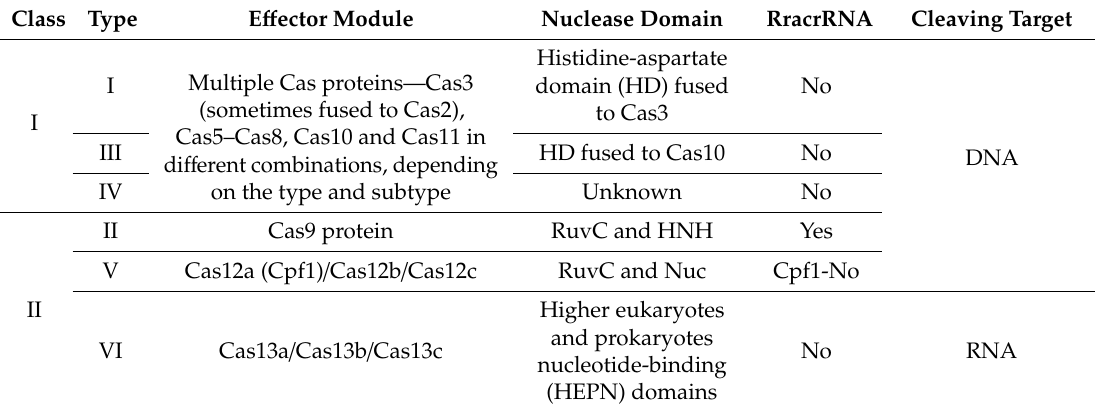
Table 1. Overview of CRISPR–Cas classification and characteristics